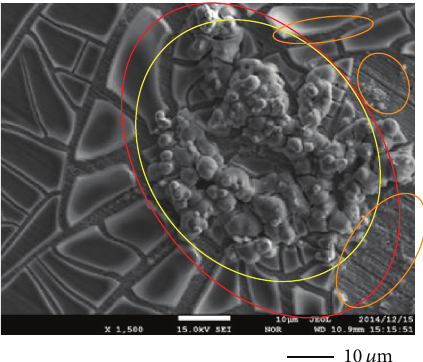
Figure 9: SEM image of Fe/TiO 2 film coated on Cu disc.